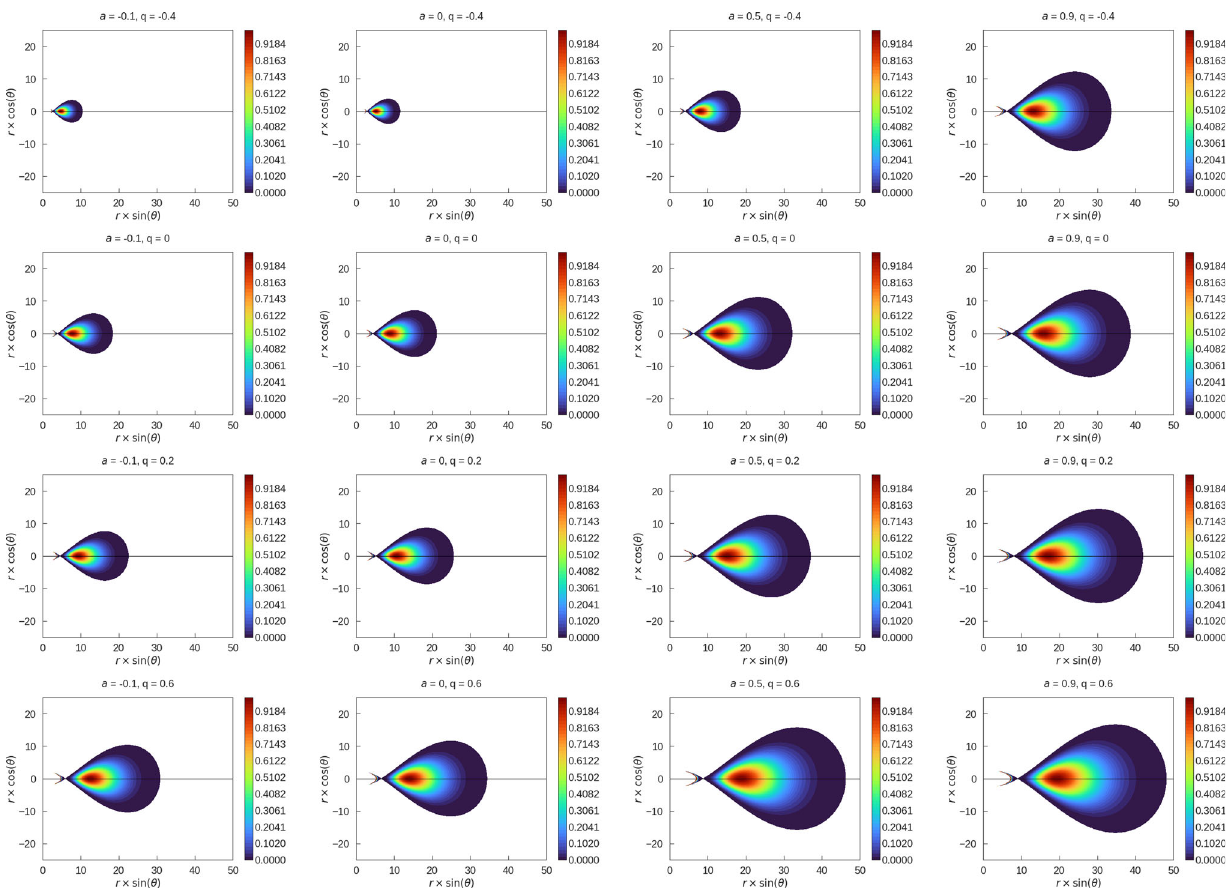
Fig. 11 Equidensity surfaces for various values of a (in column) and q (in row) considered in Fig. 9, in the stationary